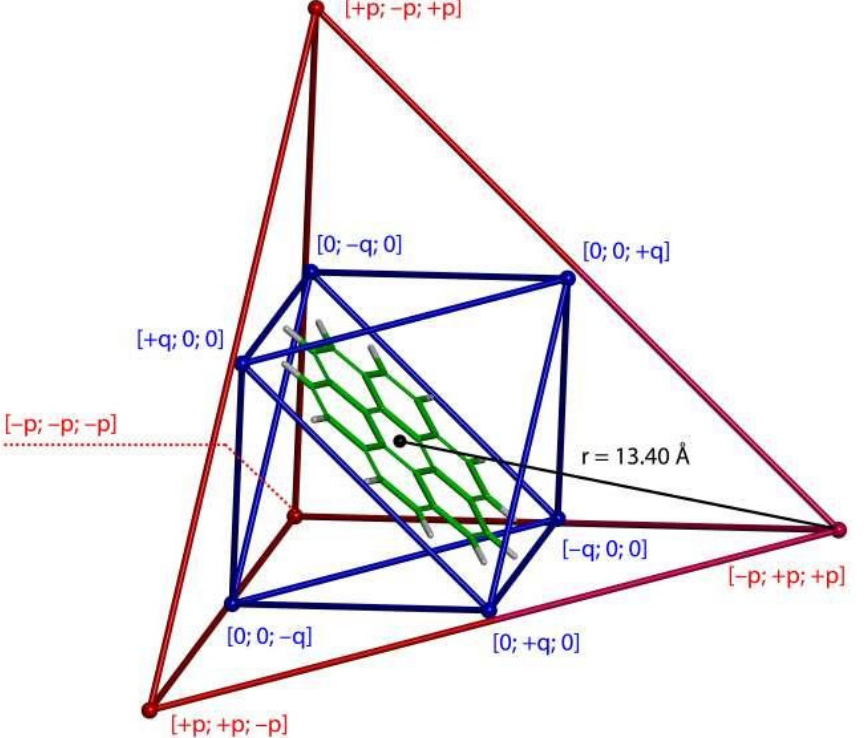
Figure 3. A schematic representation of the topology of a complex formed between one coronene molecule and the cage compound from reference [14]. This visualization uses the corresponding XRD geometry (CCSD refcode TOSQIE) and shows only the (Fe +2 ) 4 (Ni +2 ) 6 part of the cage, with coronene placed in the middle of it. The tetrahedral arrangement of Fe +2 centers is depicted in red ( p = r × 3/3, where r is the distance between the center of the cage and any of its Fe +2 vertices; Fe +2 positions are visualized as small red balls). The octahedral arrangement of Ni +2 centers is depicted in blue ( q = c × p , where c is a constant that describes the departure of Ni from the surrounding wall; in the present case c = 0.9448; Ni +2 positions are visualized as small blue balls).